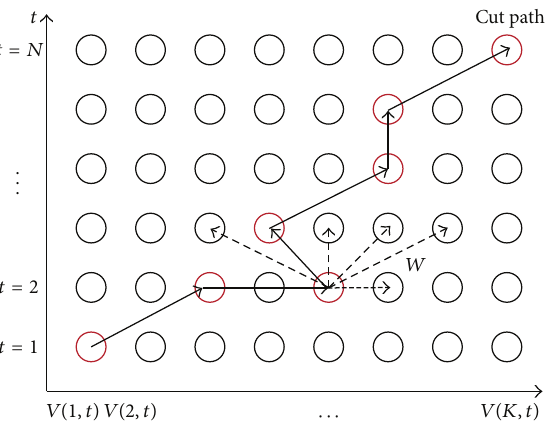
Figure 4: Graph construction in 𝑥 - 𝑡 space and its cut path for dynamic scene